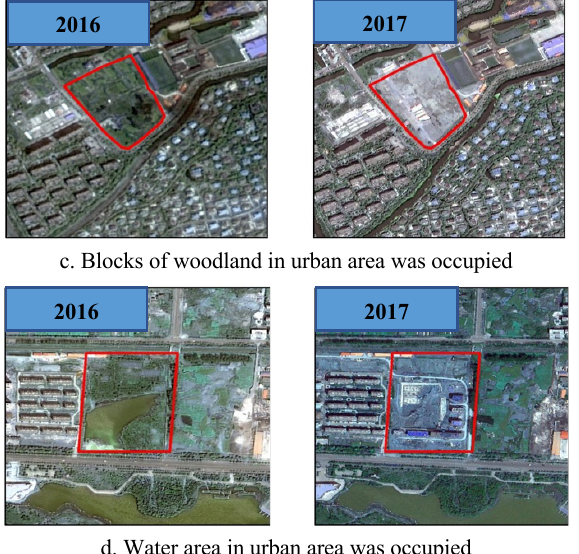
Figure 2. Schematic diagram of occupied ecological space from 2016 to